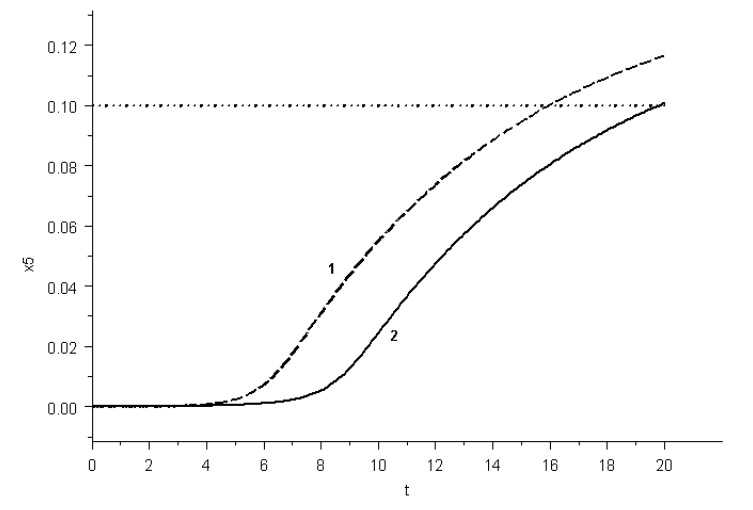
Figure 6. 1—trajectory x 5 for u = 0; 2—computational trajectory x 5